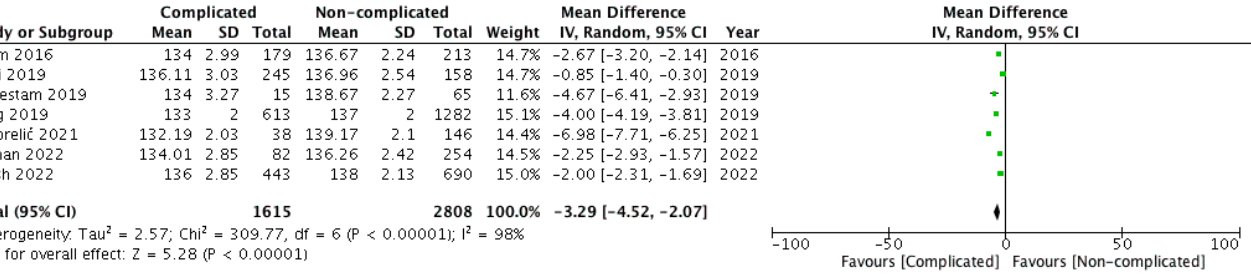
Figure 2. Forest plot comparison of serum sodium levels between the two patient groups, i.e., children with complicated (group A) versus non-complicated acute appendicitis (group B). Abbreviations: SD—standard deviation; IV—inverse variance; CI—H interval .